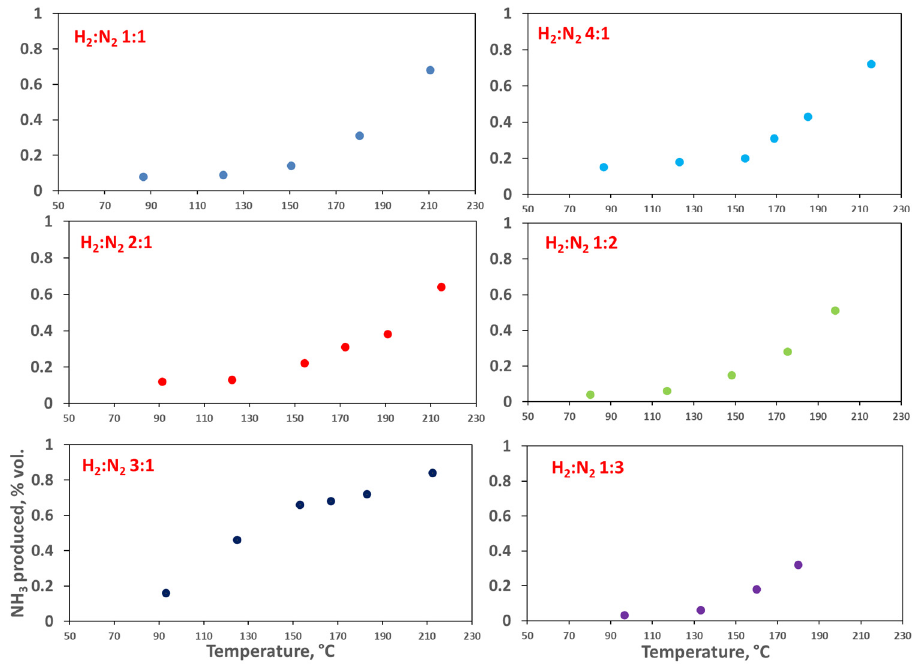
Figure 10. Effect of the feed ratio on the catalytic activity of the Ni-Zeolite 13X catalyst, 0.5 L (g cat h) − 1 . In the figure, the produced NH 3 (vol%) is reported vs T.